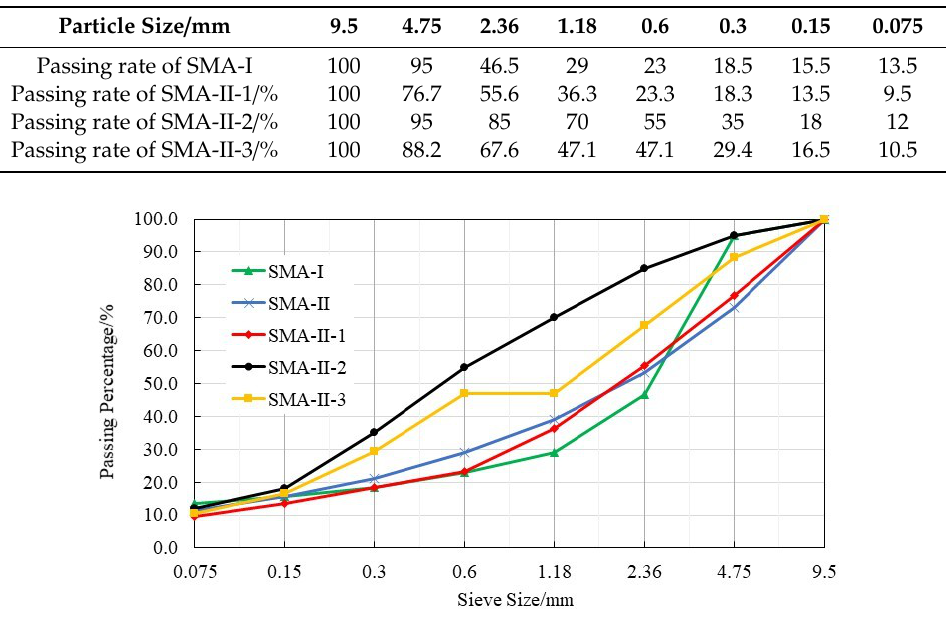
Figure 3. Gradation curves of SMA- Ⅰ and SMA- Ⅱ .